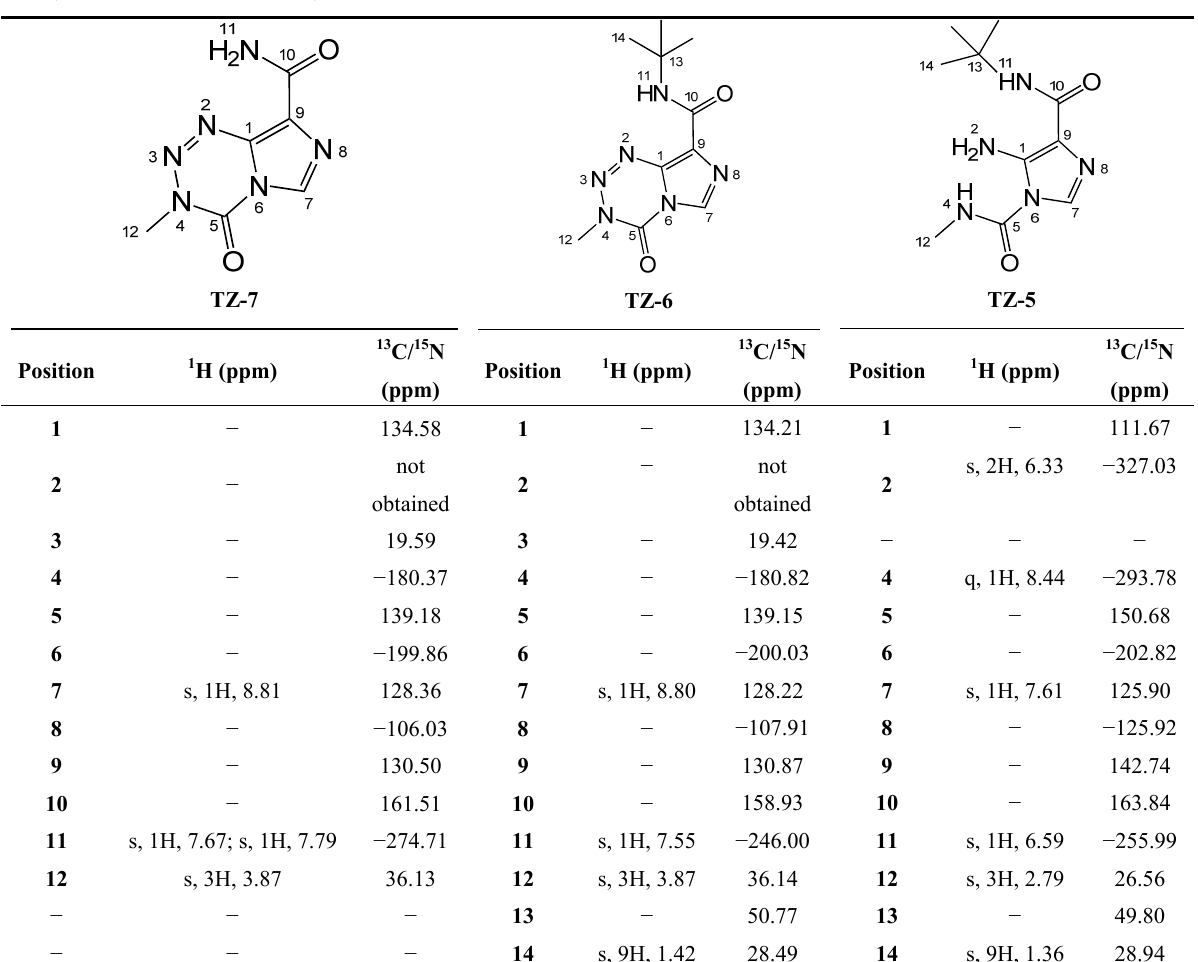
Table 1. Signal assignment for TZ-7 , TZ-6 and TZ-5 in 1 H- 13 C- and 15 N-NMR spectra, (in DMSO-d 6